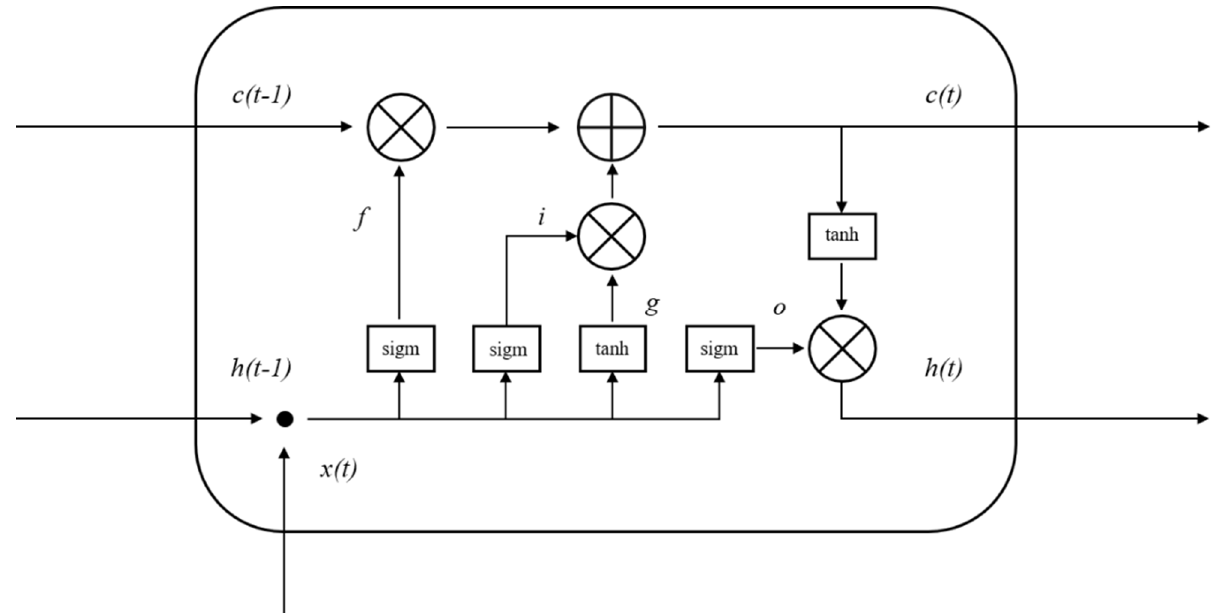
19 of 28 Figure 11. Schematic view of recurrent neural network (RNN) model. In graph, arrow on left side indicates neurons of CNN; x ( t ) and y ( t ) are put as an input and output step respectively. The right-side graph shows the RNN expansion architecture. Respectively, u , v and w are the weight matrices corresponding to the input, output and hidden states. The same time states share one weight matrix, which greatly reduces the number of parameters in the model to be learned. Long short-term memory (LSTM) is a variant of RNN that can learn long-term de-